Question: Sum up the contents of this chart in one sentence.
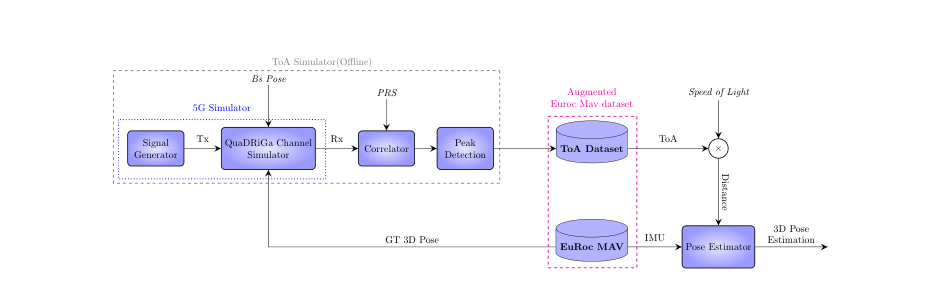
Answer: System Architecture for Augmentation of EuRoC MAV Dataset with 5G Simulation.